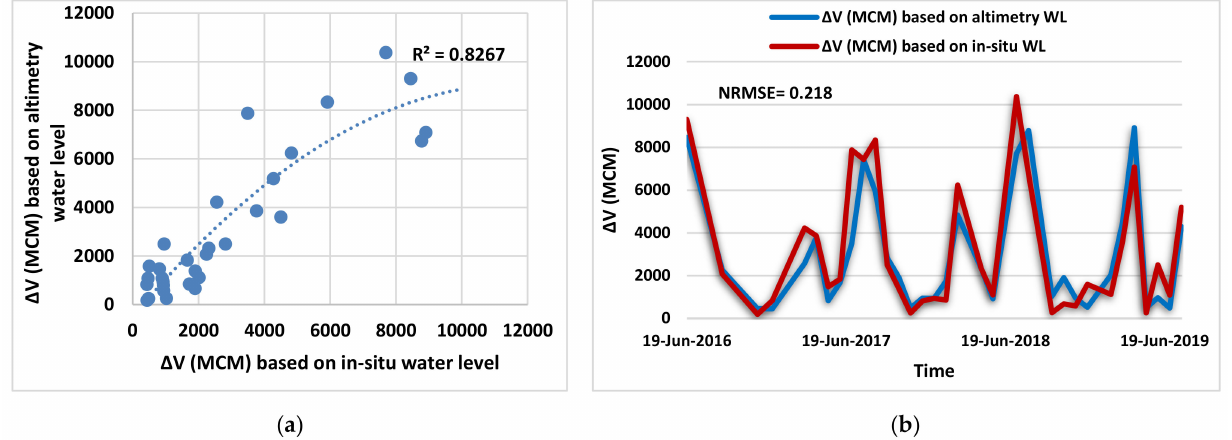
Figure 13. The results of estimating water volume variations ( ∆ V) by applying Heron’s formula. ( a ) Relation between estimated ∆ V by Sentinel-3 altimetry water level and in situ water level in MCM using Heron method. ( b ) Water volume variations estimated by Heron method over a time period with NRMSE value between altimetry water level and in situ water level.